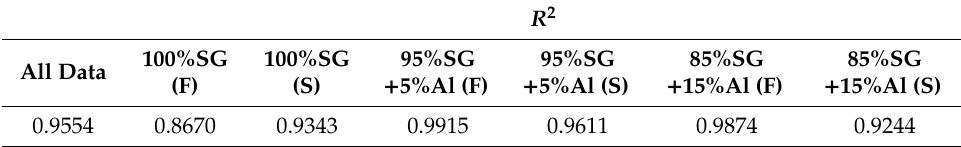
Table 5. Coe ffi cient of determination R 2 for the Linear Fit Table 4. Coefficient of determination R 2 for the Linear Fit (70-15-15).